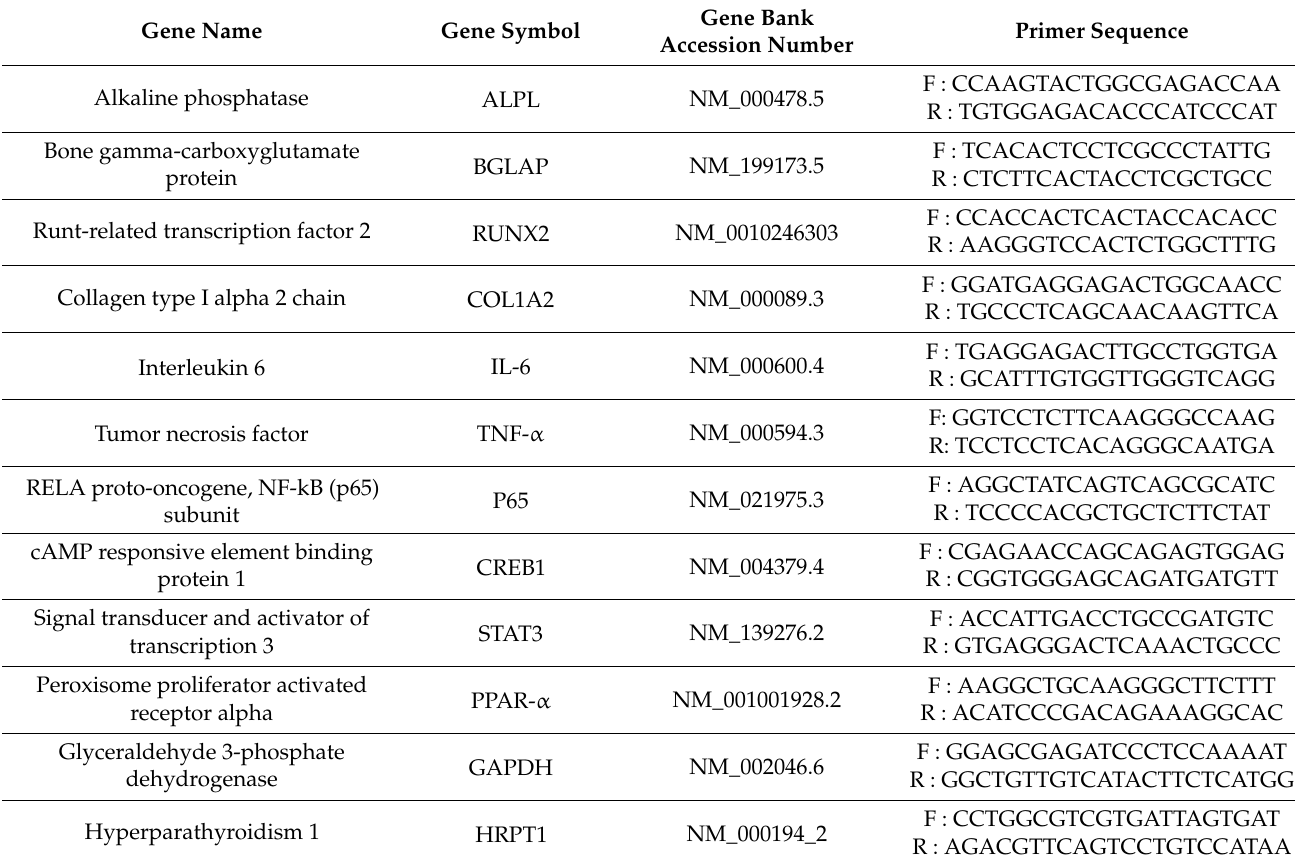
Table 1. Primer sequences of the target and reference